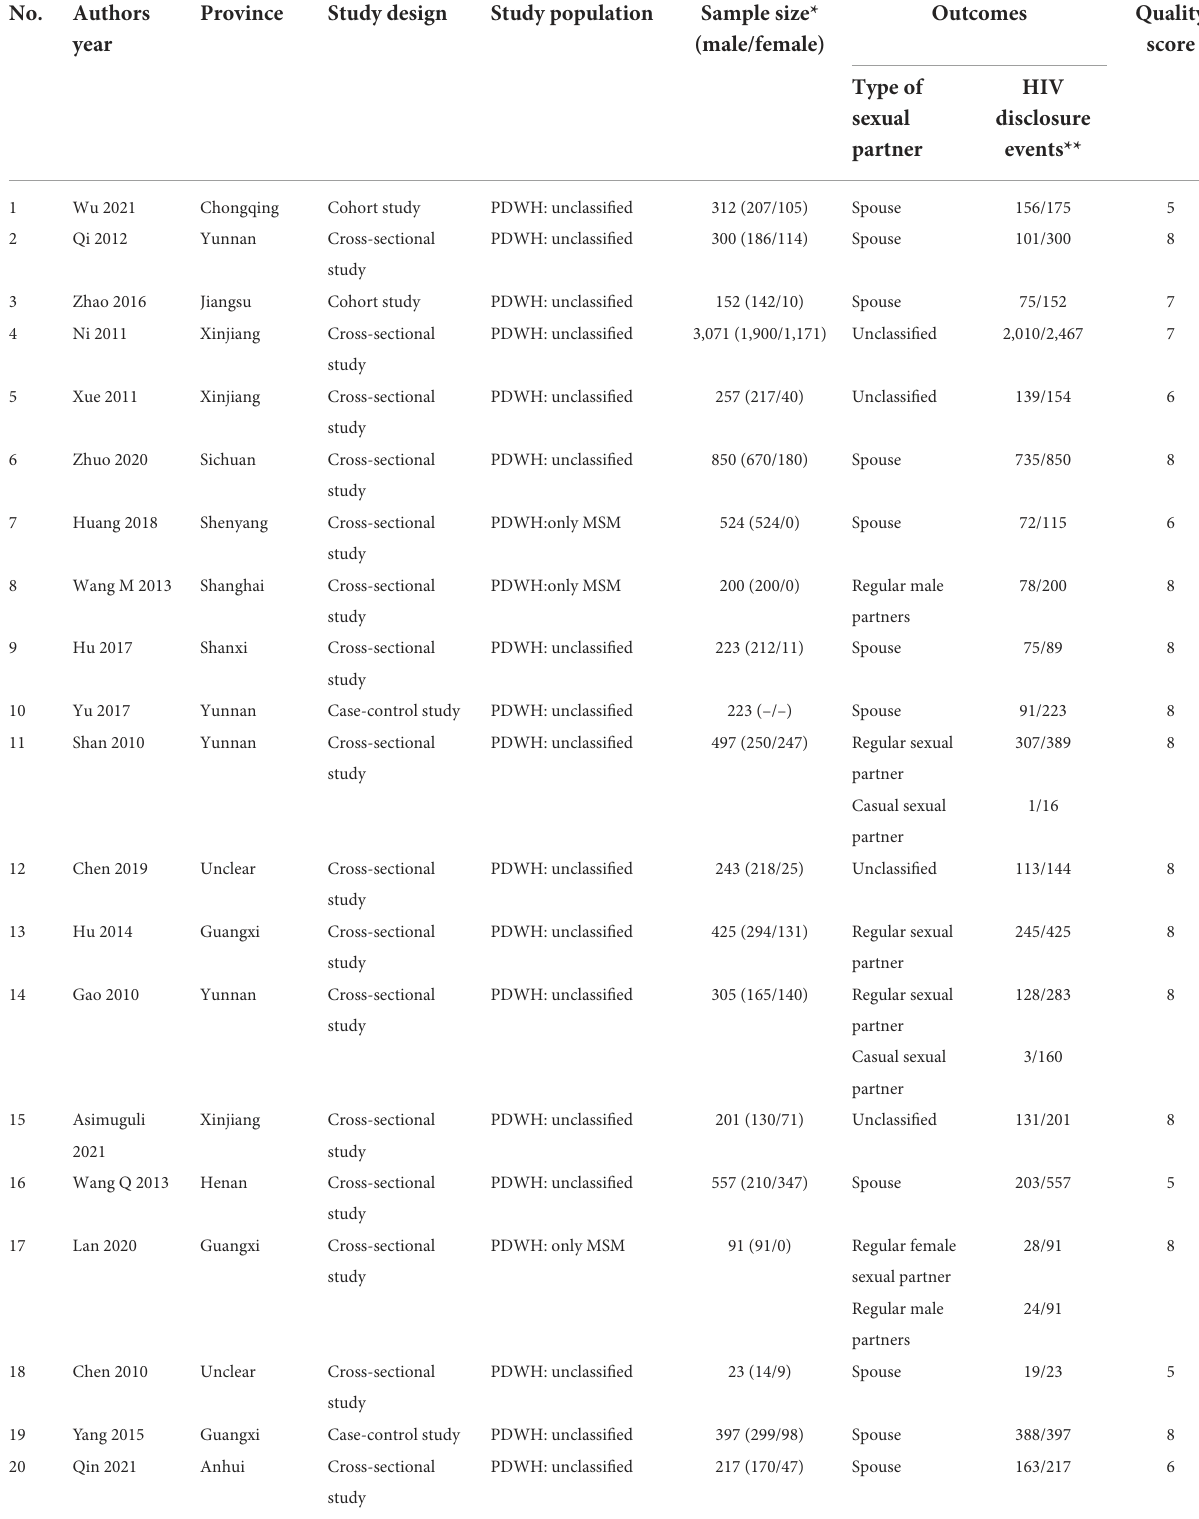
TABLE 1 Characteristics and quality of included